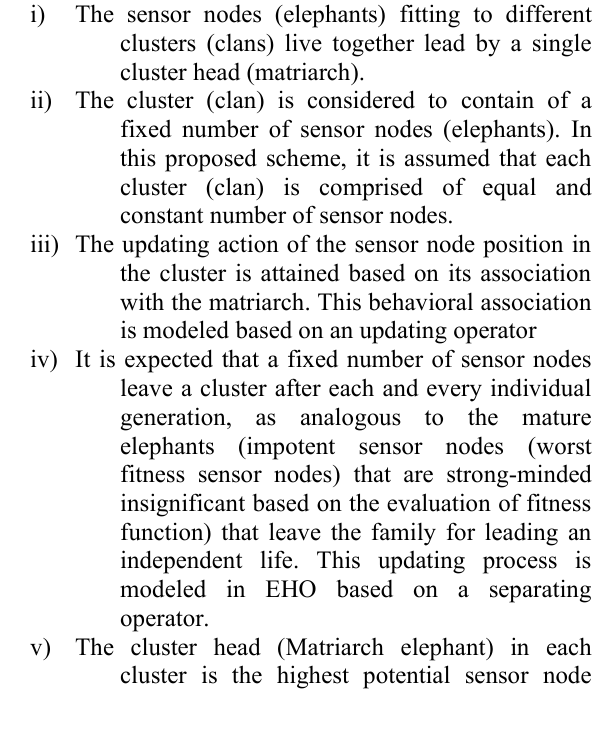
Algorithm-based optimal cluster head